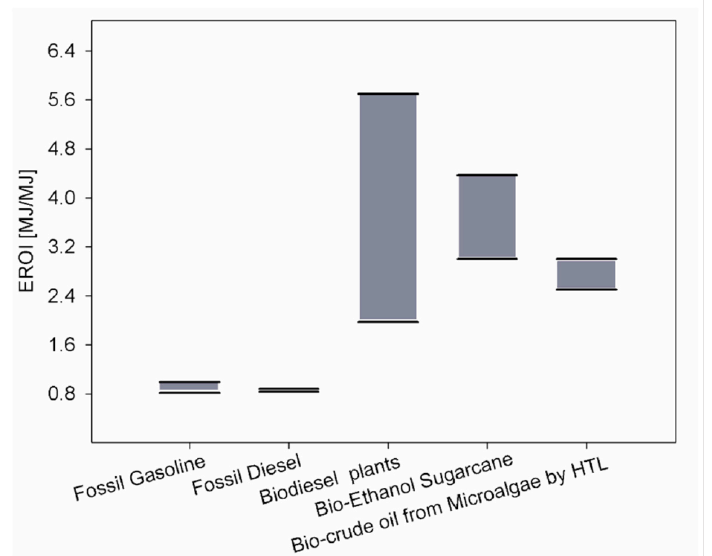
Figure 4. Energy in return of investment values for various pathways of biofuels from terrestrial plants and microalgae